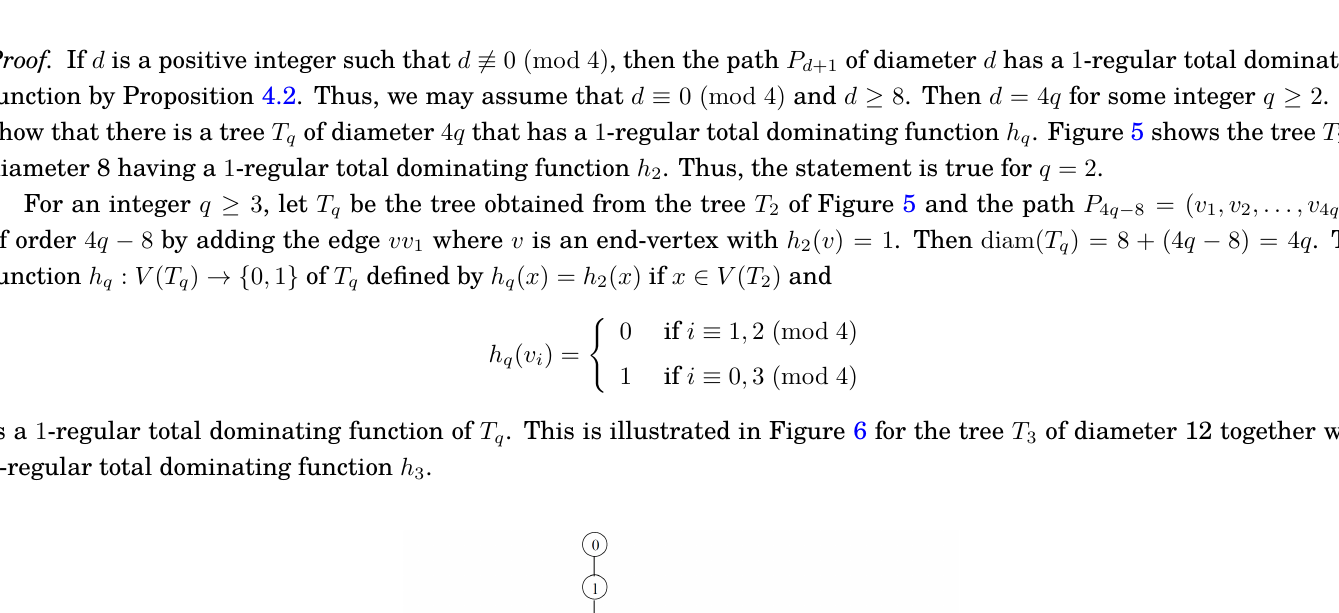
Figure 5: A tree of diameter 8 having a 1 -regular total dominating function.